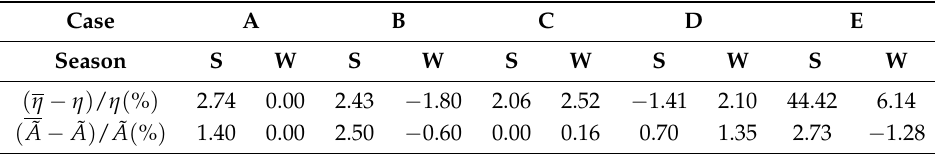
Table 1. Wave amplitude comparison. S is summer, W is